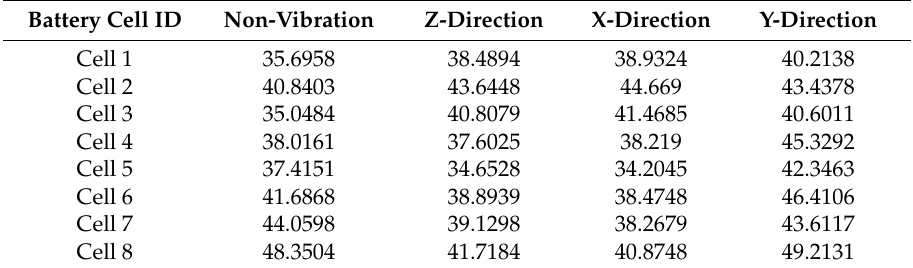
Table 8. The resistance of batteries under the non-vibration and the vibration conditions applied in the